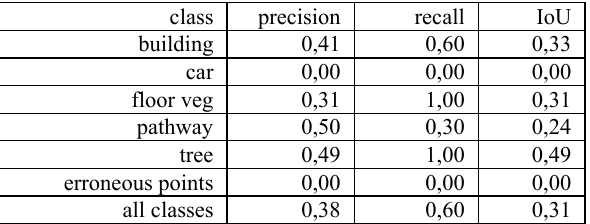
Table 2. Results investigation using point clouds with erroneous points. Using the parameters of the precision, recall and IoU.